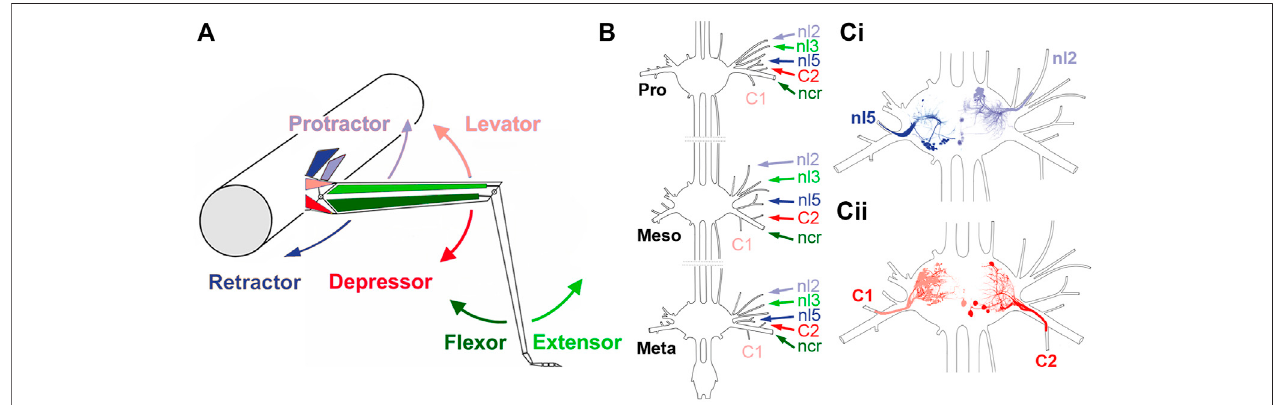
FIGURE1| Summaryofthestickinsect legsegments,withanoverview ofthethoracic ganglia andrelevantnerves. (A) Schematicrepresentation ofthemiddleleg and the mesothoracic body-segment, with the location of the muscles responsible for the movement direction that is depicted by the arrows. (B) Sketch of the three thoracicgangliainthestickinsectandthelocationoftherelevantlegnervesthatarebeingrecordedinthisstudy(Pro:prothorax,Meso:mesothorax;Meta:metathorax). (Ci,Cii) Sketches of a mesothoracic ganglion, showing the location of motor neurons of protractor (nl2) and retractor coxae (nl5) motor neurons (Ci) , and levator (C1) and depressor trochanteris (C2) that project through the respective lateral leg